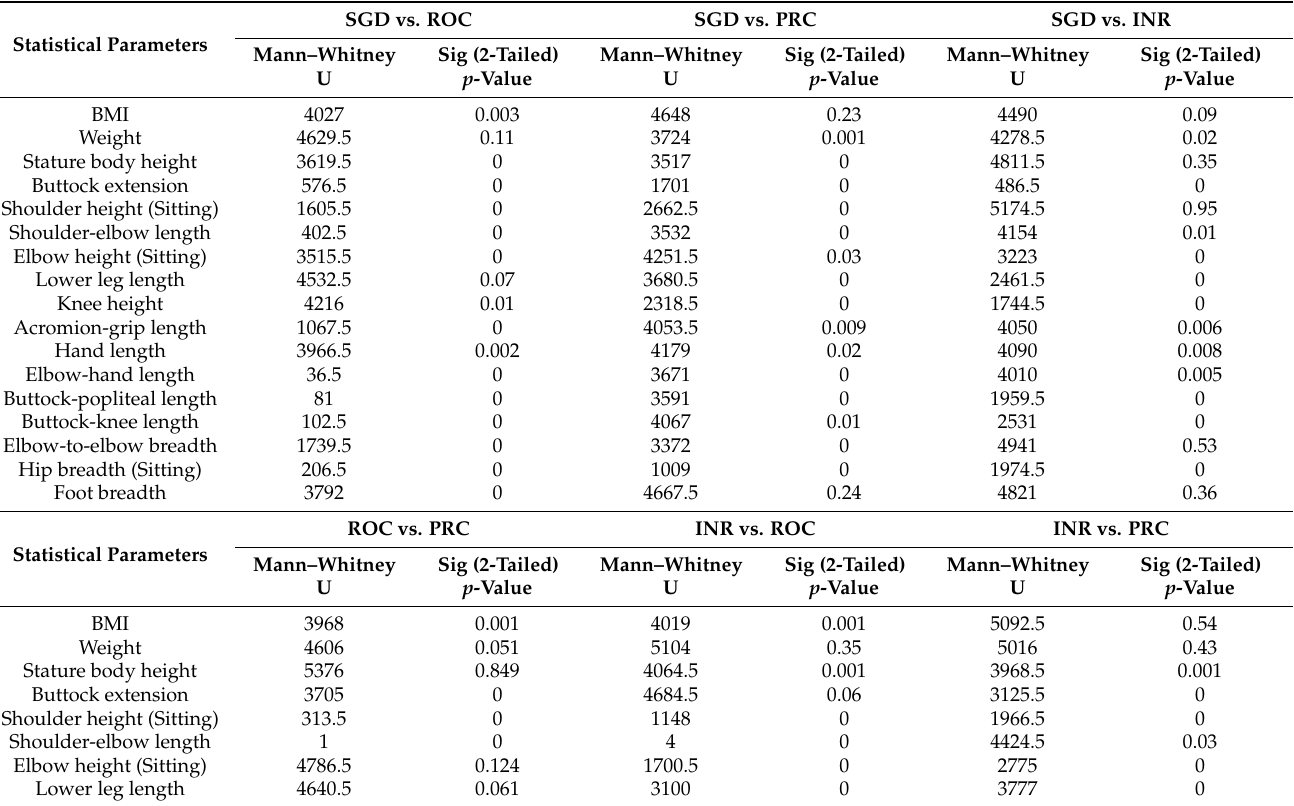
Table 4. Results of Mann–Whitney U